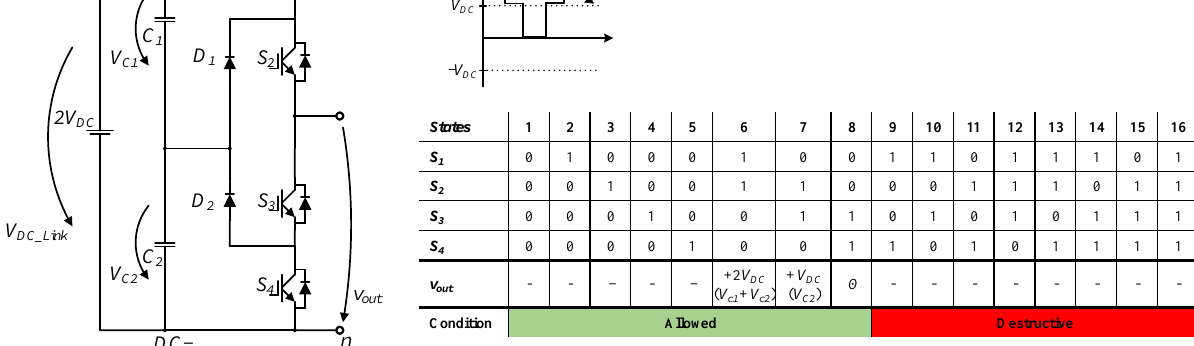
Figure 7. Submodule NPC topology for cascaded applications and operation